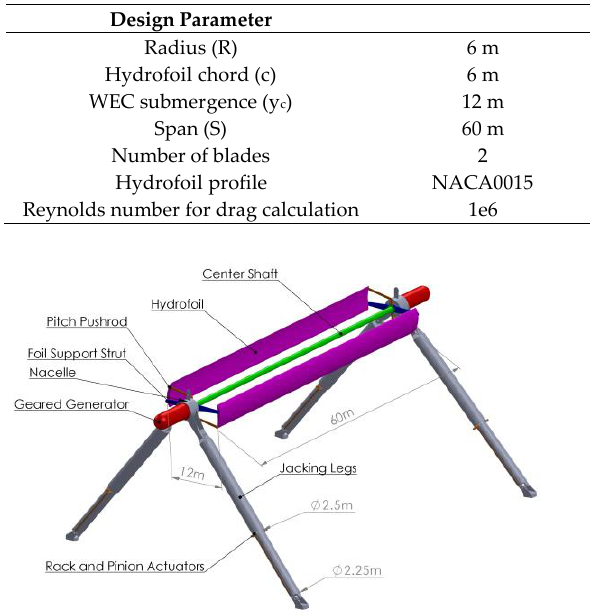
Figure 2: 3D model of the ocean scale CycWEC showing different components of the mechanical